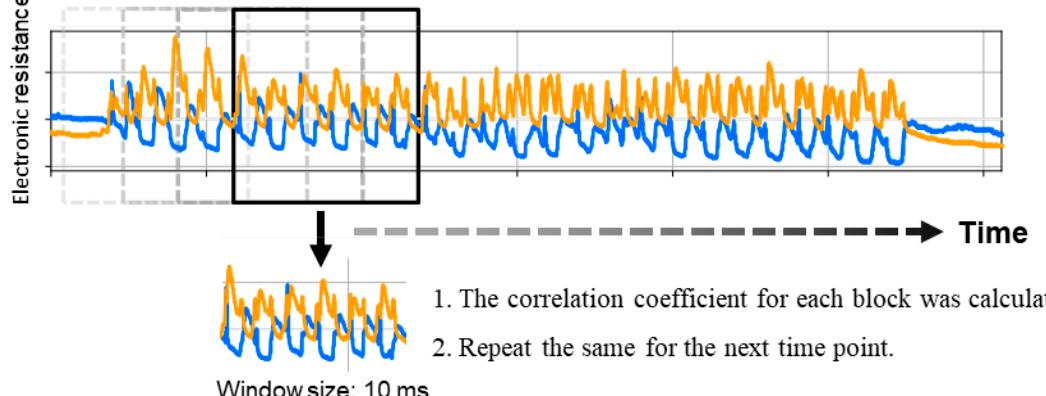
Figure 4. Method of calculation of the correlation coefficient transition from raw data. A part of the data was extracted as a block of 10-ms width; the correlation coefficient was calculated based on the value in the block, and this calculation was performed from beginning to end, with an interval of 5 ms.